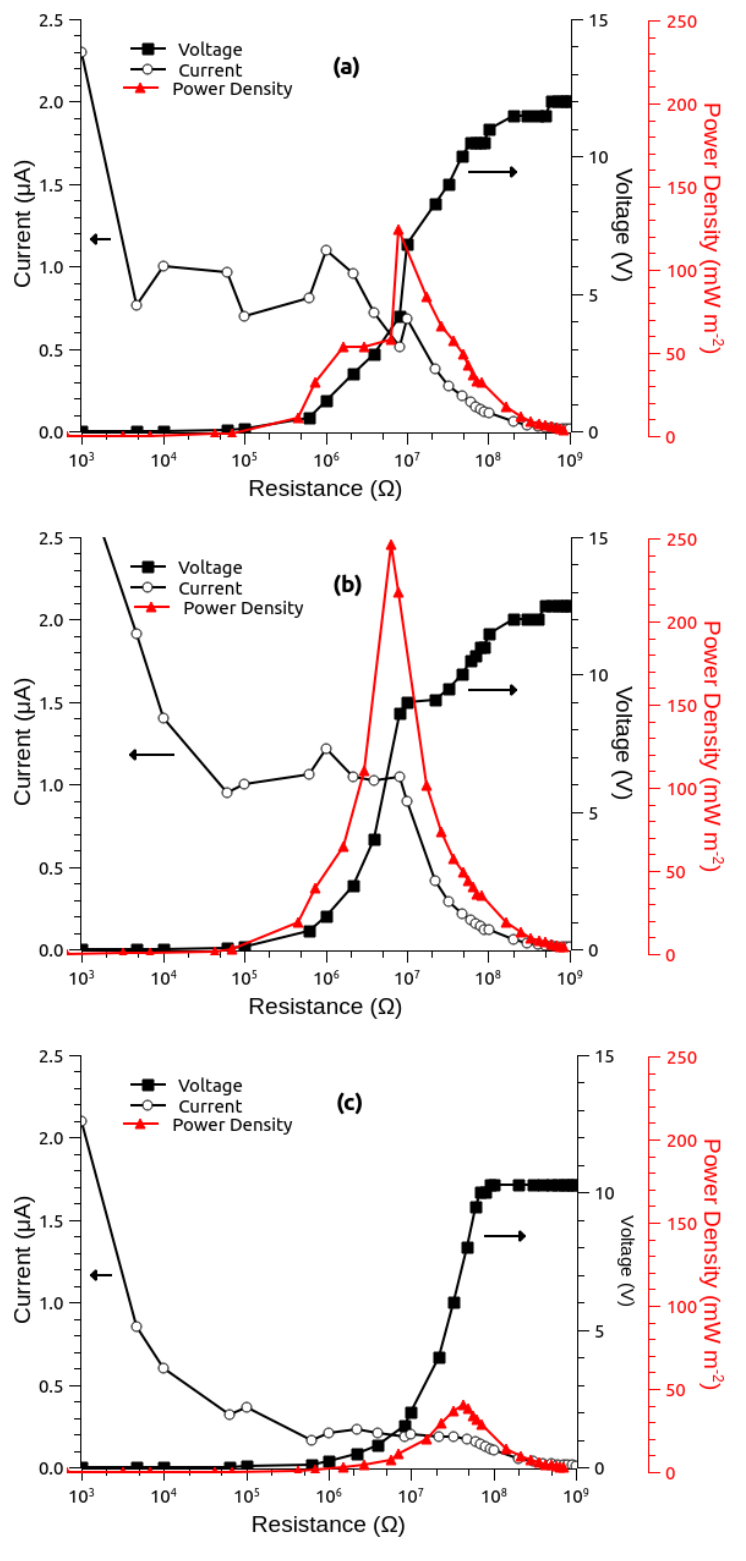
Figure 8. Voltage, current, and power density versus resistance obtained from the triboelectric devices assembled by using ZnO NRs with a steel spring blade and PDMS:GO 4% weight: ( a ) 45 Hz; ( b ) 60 Hz; ( c ) 200